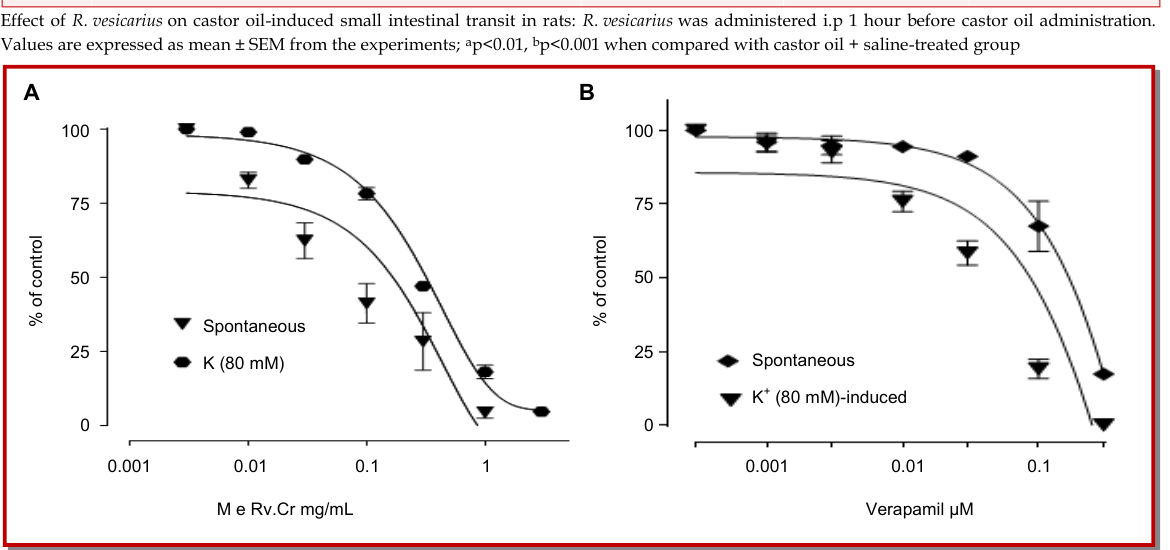
Figure 1 : Concentration response curves showing the inhibitory effect of R. vesicarius (A) and verapamil (B) on spontaneous and K + (80 mM)-induced contractions in isolated rabbit jejunum preparations. The values shown are mean ± SEM of 5